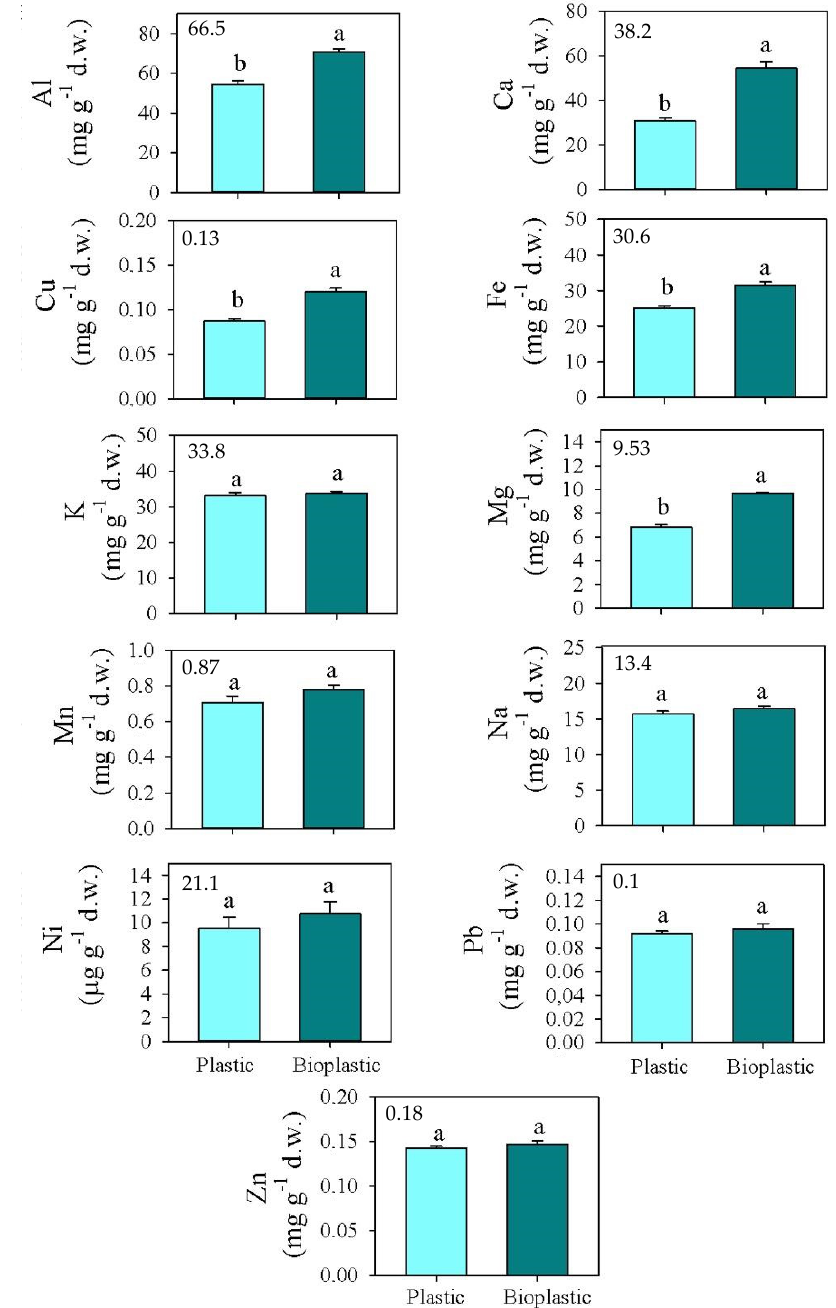
Figure 1. Mean values ( ± s.e.) of total Al, Ca, Cu, Fe, K, Mg, Mn, Na, Pb, and Zn (expressed as mg g − 1 d.w.), and Ni (expressed as µ g g − 1 d.w.) concentrations measured in soils at T0 ( top left ) and after six months of exposure to plastic (light blue) and bioplastic (dark blue). Different small letters indicate statistically significant differences between soils covered by plastic and bioplastic, respectively (one-way ANOVA; p < 0.05).